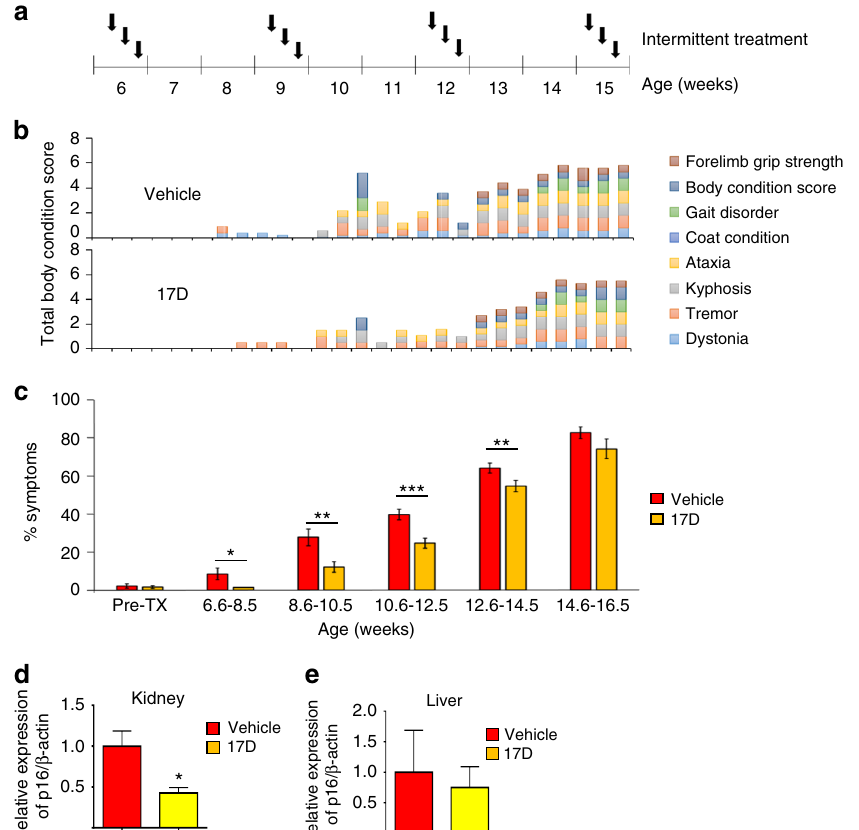
Fig. 9 Intermittent treatment of progeroid Ercc1 − / Δ mice with the senolytic HSP90 inhibitor 17-DMAG extends healthspan. a Schematic diagram of the in vivo treatment regiment. Animals were treated with 10 mg/kg 17-DMAG by oral gavage 3 times per week, every 3 weeks. Eight symptoms associated with frailty and aging were measured in the mice, 3 times each week. b Graphed is the age at onset of each symptom (appearance of a colored bar ) and severity (height of the bar) for a sex-matched sibling pair of Ercc1 − / Δ mice treated with or without 17-DMAG. The composite height of the bar is an indication of the overall health (i.e., body condition score with a higher value being worse). c Comparison of age-related symptoms between cohorts of mice treated with the HSP90 inhibitor or vehicle only over time. The average fraction of total symptoms appearing in each age group is plotted. An increase in the percent of symptoms indicates a decrease in health. n = 6 mice per treatment group, error bars indicate SEM, * p < 0.05, ** p < 0.01, *** p < 0.001. Relative expression levels of p16 INK4a in kidney d and liver e of Ercc1 − / Δ mice treated for 1 week by oral gavage with HSP90 inhibitor (10 mg/kg 17-DMAG oral gavage per treatment, 3×) compared to vehicle only. p16 INK4a was measured by qRT-PCR. n = 4 mice per group; error bars indicate SD, * p < 0.05, two tailed Student t